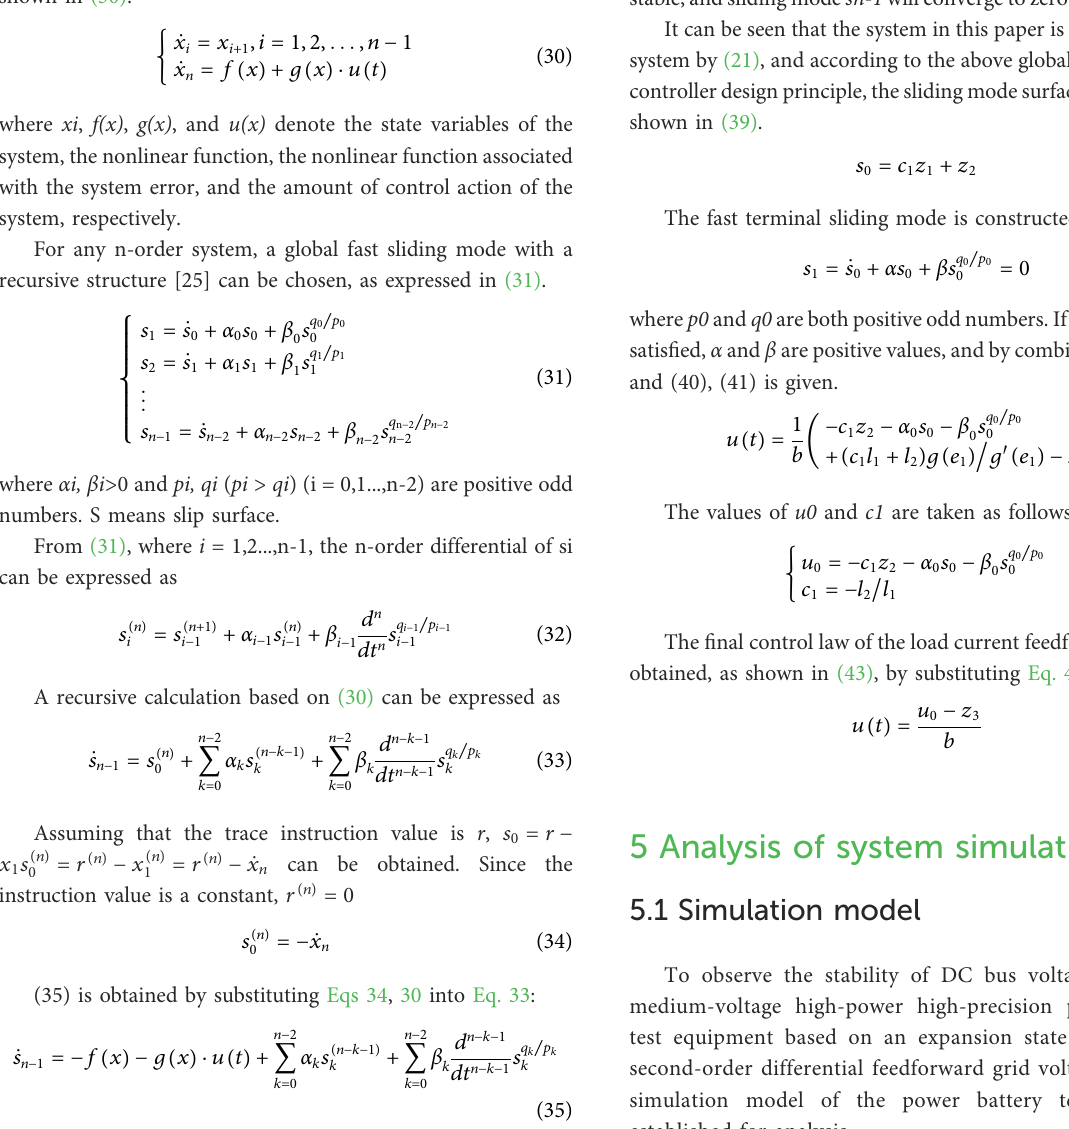
Figure 9. The model contains the grid, AC/DC converter, DC/DC converter, power battery pack of electric vehicles, AC output isolation transformer, and AC load. The load power battery pack module parameters are shown in Table 1. The DC/DC converter is connected to the AC/DC converter by a bus capacitor. The DC output voltage of the DC/DC converter can be controlled from 50 to 1600 V. The DC voltage range at the AC/DC and bus capacitor connection is from 1300 to 1650 V. A rated power of 850 kW could be obtained for the AC-DC converter, which meets the rated ef fi ciency